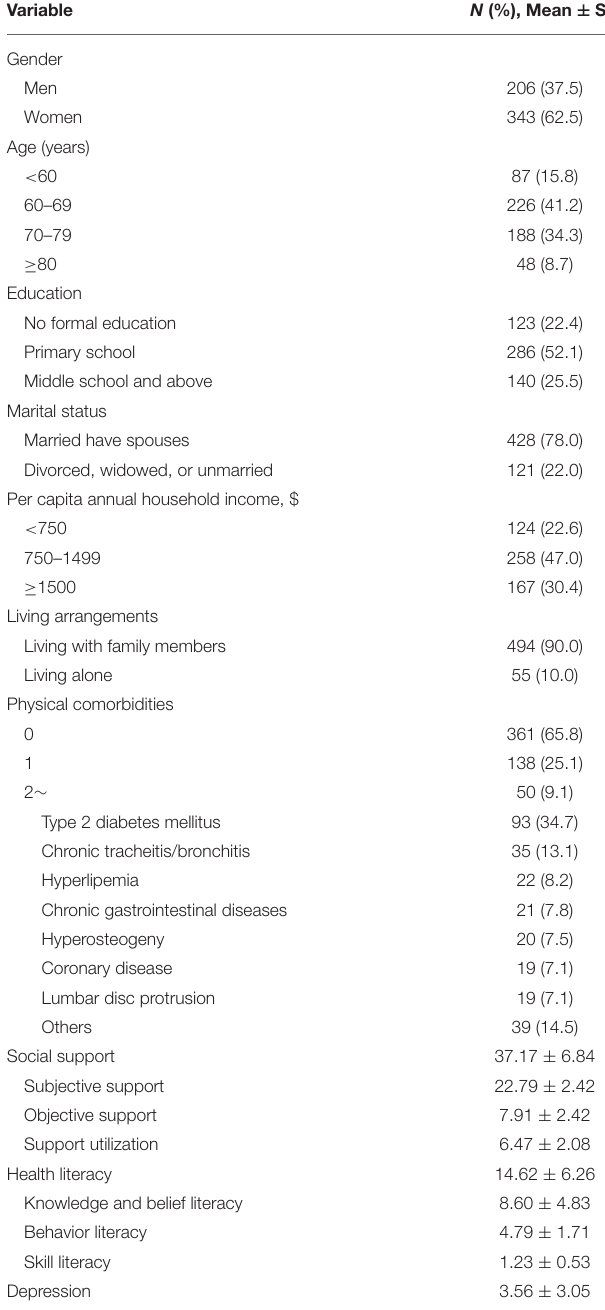
TABLE 2 | Descriptive results of the